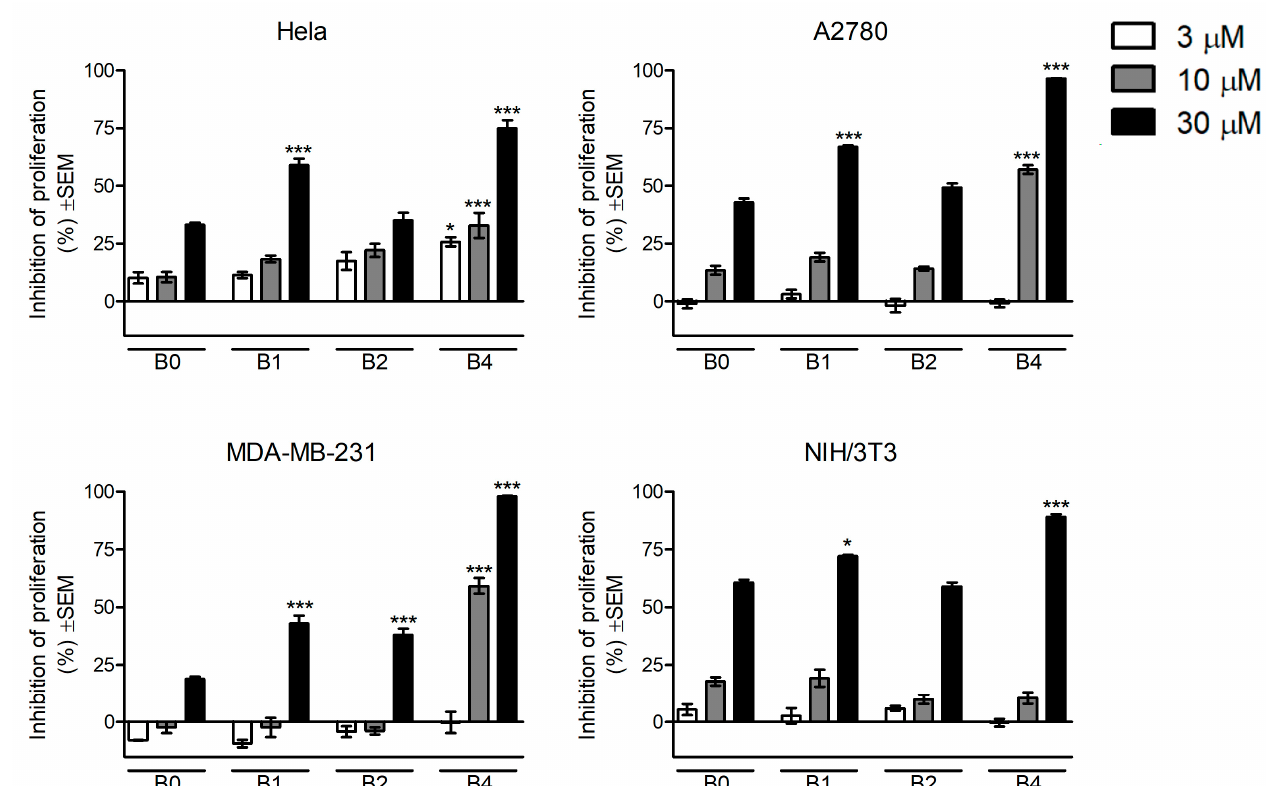
Figure 5. Changes in cell viability of cancer cells caused by the solutions of bexarotene following photocatalytic degradation experiments in HeLa, A2780, MDA-MB-231, and NIH/3T3 cells. Cells were treated with 3, 10, and 30 µ M of bexarotene solutions after UV irradiation (B0—without irradiation, B1—1 h, B2—2 h, and B4—4 h of irradiation); * p < 0.05 and *** p < 0.001.